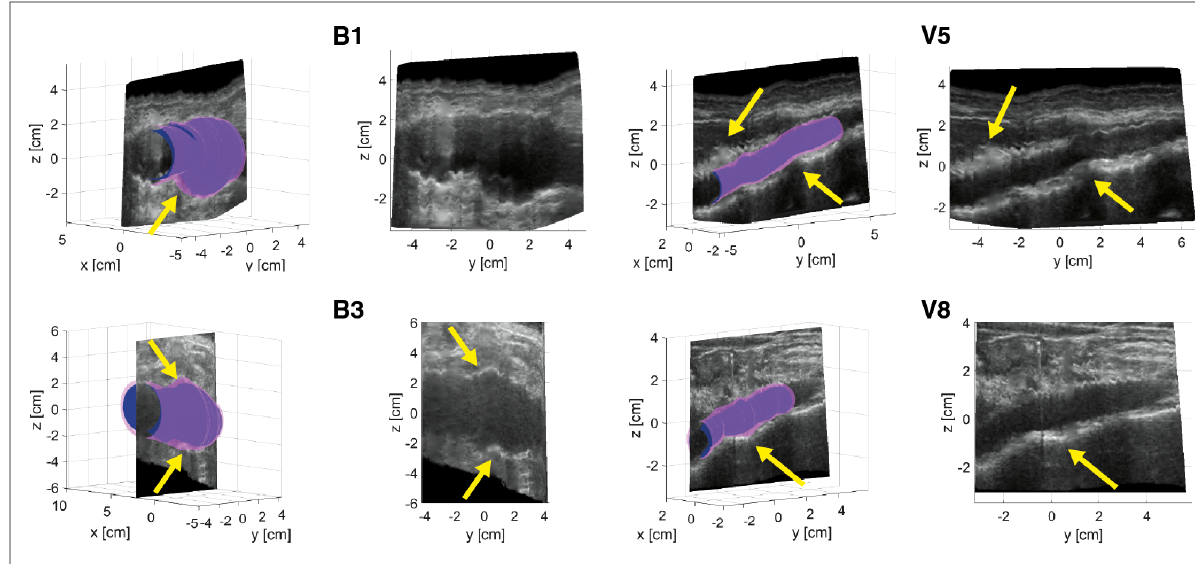
FIGURE 2 Examples of ED (blue) and ES (purple) geometries of AAAs of patients B1 and B3 and healthy aortas of volunteers V5 and V8. A longitudinal cross- section reconstruction extracted by interpolation of the individual series of US frames is shown separately and together with the geometries. Yellow arrows point at regions of large geometry changes in AAAs and poor image quality regions of healthy aortas.